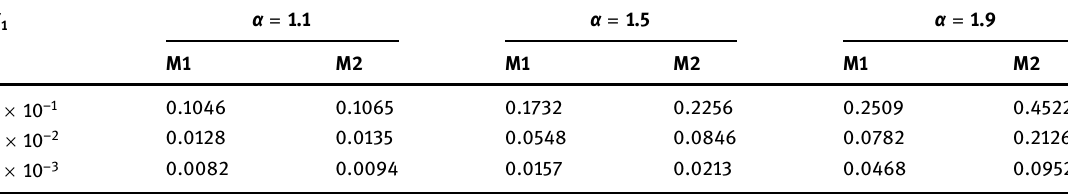
Table 2: The relative errors of Example 2